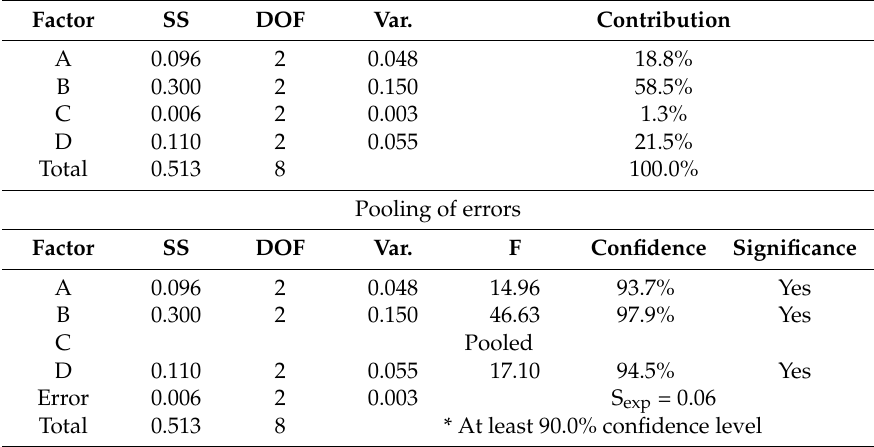
Table 7. Variance analysis table of signal-to-noise (S/N) ratio for hardness.